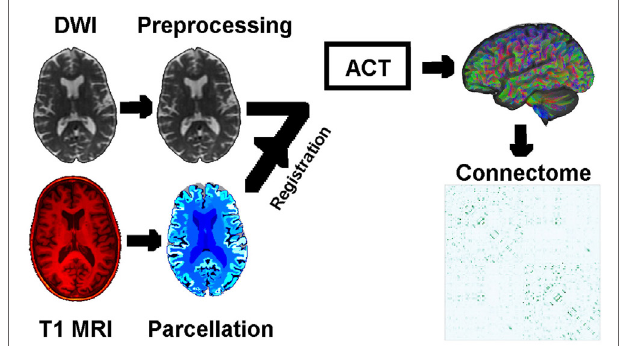
FigUre 1 | Schematic of the image analysis pipeline, per individual: DWI preprocessing → DWI normalization → rigid registration of T1 MRI to DWI → T1 parcelation → anatomically constrained tractography → connectomes based on density of WM neuronal connections between GM regions of interest. Abbreviations: DWI, diffusion-weighted image; MRI, magnetic resonance image; ACT, anatomically constrained tractography; WM/GM, white/gray matter.